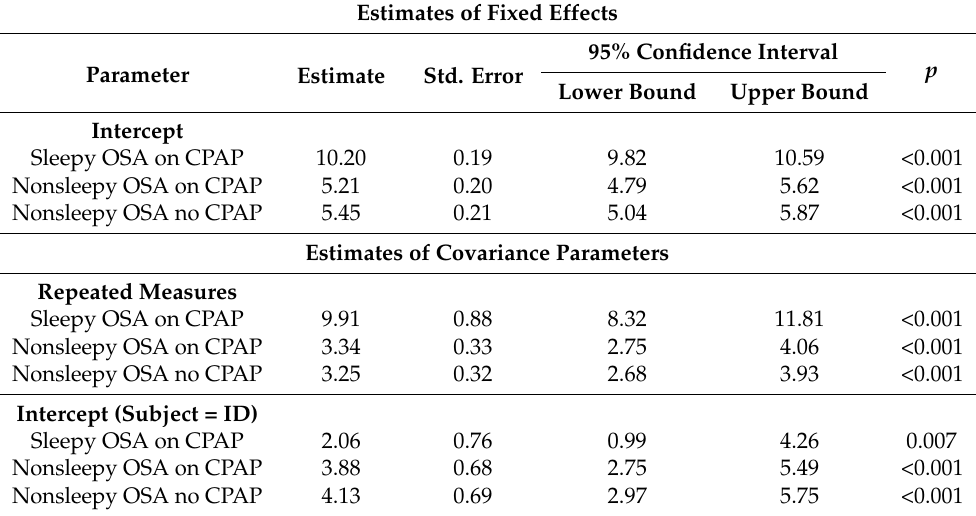
Table 3. Parameters of the Null